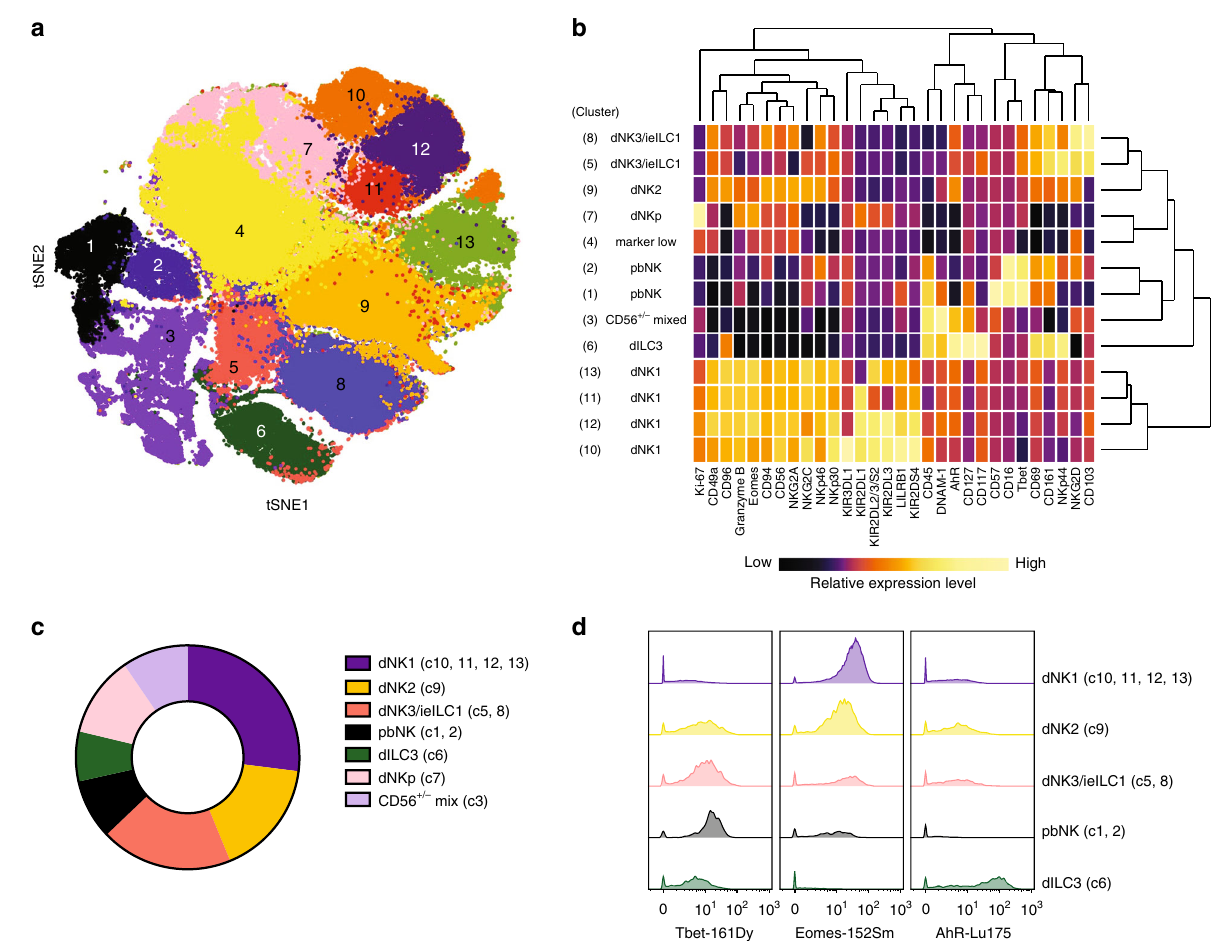
Fig. 2 Characterisation of dILC subsets. a Density-based local maxima cluster With SVM (DensVM) clustering of CD45 + Lin − (CD3,CD19,CD14,HLA- DR) cryopreserved decidual cells using mass cytometry data on markers indicated in Supplementary Table 1 ( n = 12). b Heatmap displaying mean expression of indicated markers across the 13 annotated clusters. Values have been scaled by column to show relative expression. c Donut plot showing the average frequencies of identi fi ed clusters from cryopreserved decidual cell preparations ( n = 12). d Representative histograms for transcription factors across denoted subsets: dNK1-3, ILC3, dNKp, and pbNK. Clusters representing each subset are shown in brackets. Source data are provided as a Source Data fi le.